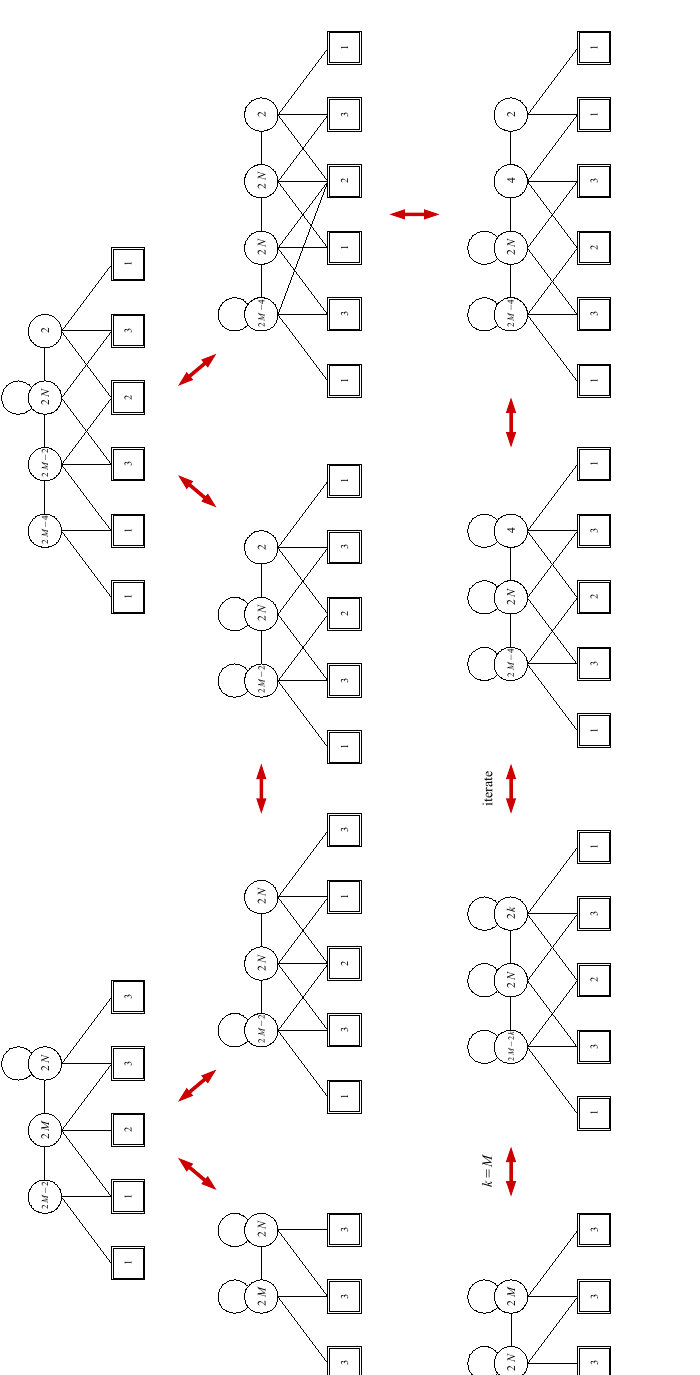
Figure 11 . Sketch of the manipulations we perform on the original theory to obtain the cross-leg duality. We avoid drawing singlets not to clutter the